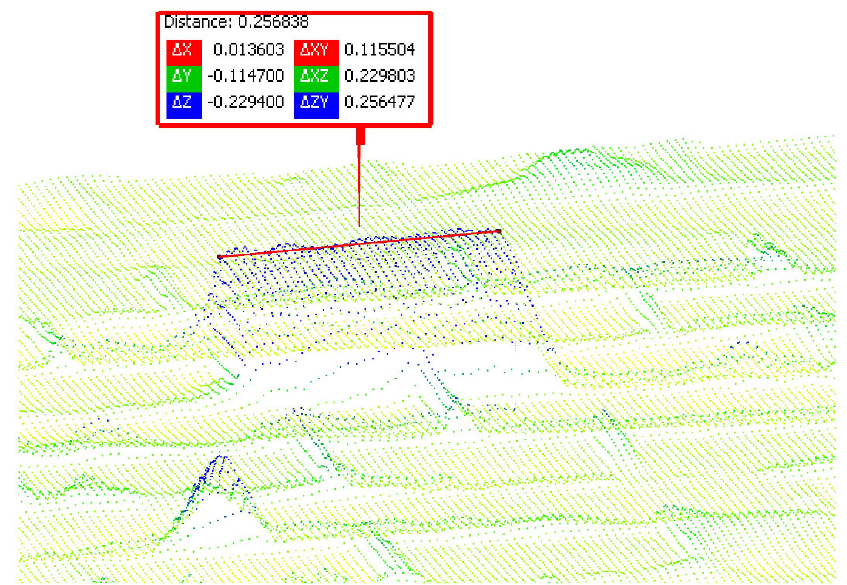
Figure 6. Dimensioning of cavity no. 2.